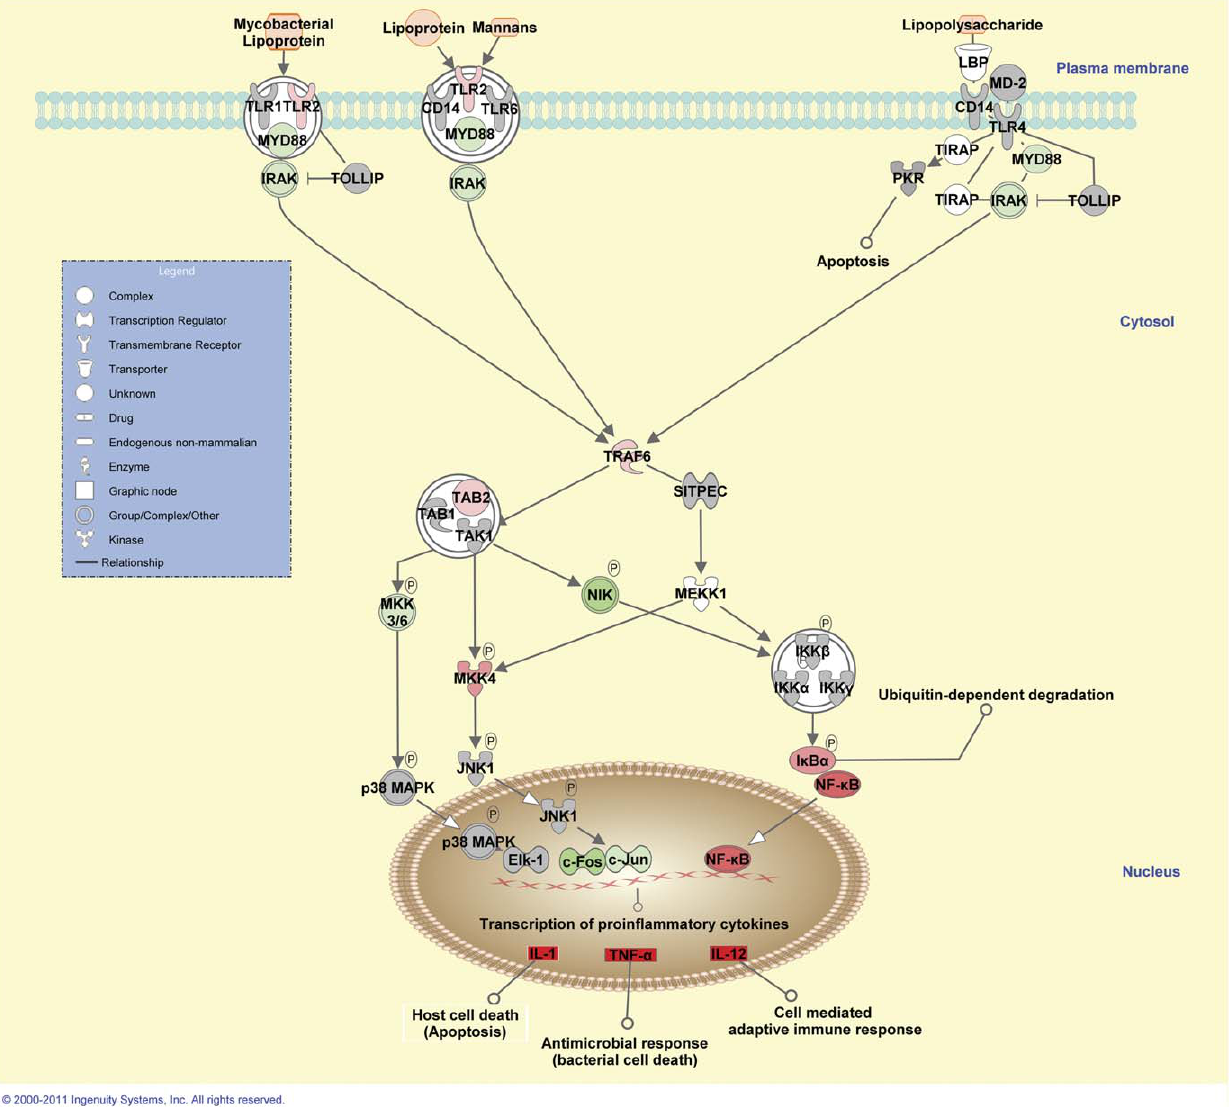
Figure 4. Differential gene expression in the TLR signalling pathway 2 hours post- M.bovis challenge. Genes within the TLR signalling pathway showing differential expression are highlighted in colour. Colour intensity indicates the degree of upregulation (red) or downregulation relative to the control MDM. Grey shading indicates genes that were not differentially expressed; white shading represents genes in the pathway not represented on the microarray; mycobacterial PAMPs are shaded orange.